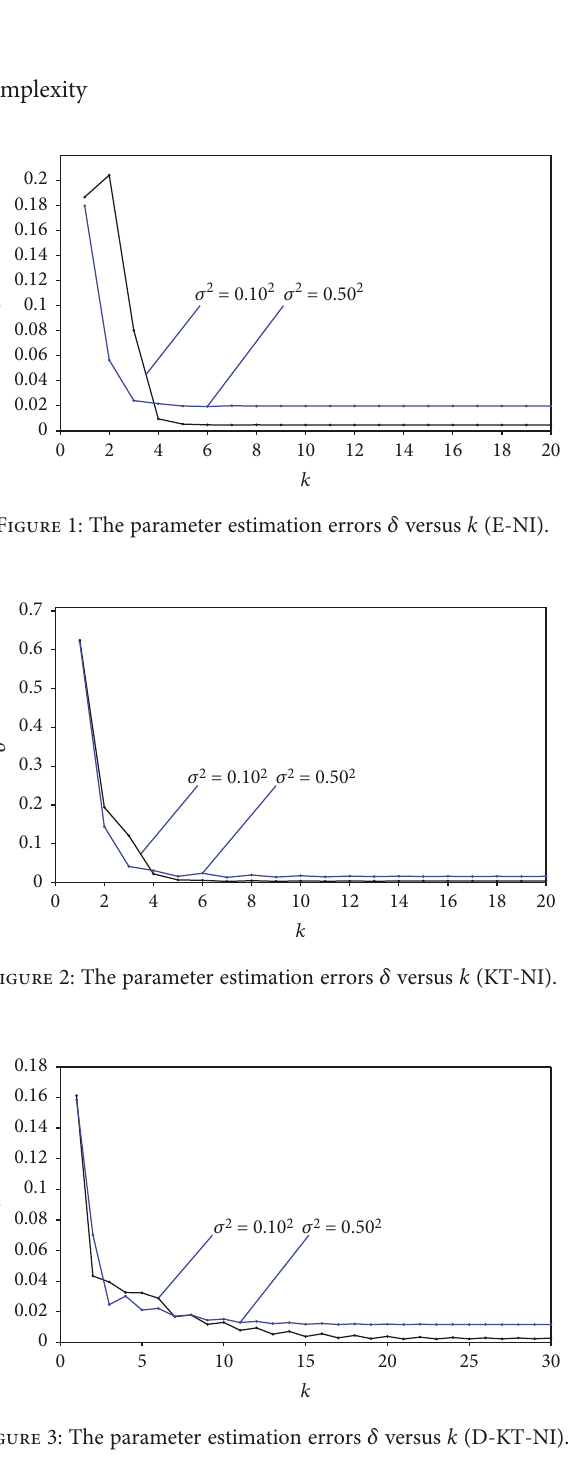
Figure 3: The parameter estimation errors δ versus k